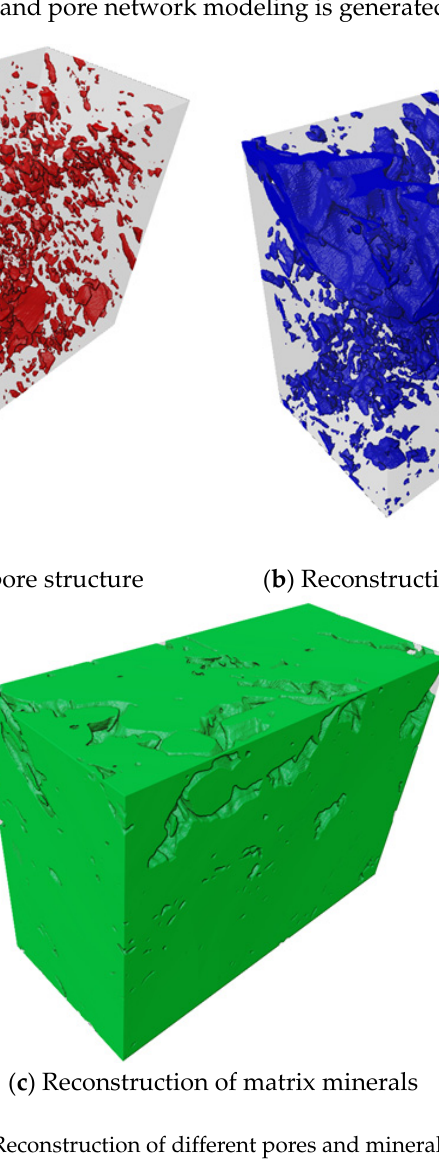
Figure 11. Image segmentation and structure extraction with different compositions.